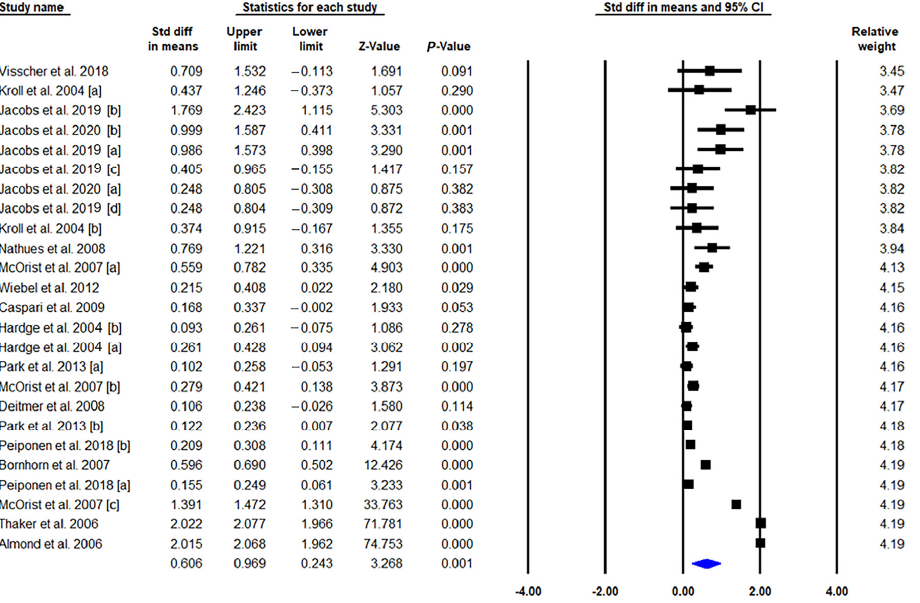
Figure 2. Meta-analysis forest plot of the effect of the commercial vaccines against L. intracellularis on ADWG for each of the trials using the pooled standardized mean difference (SMD).